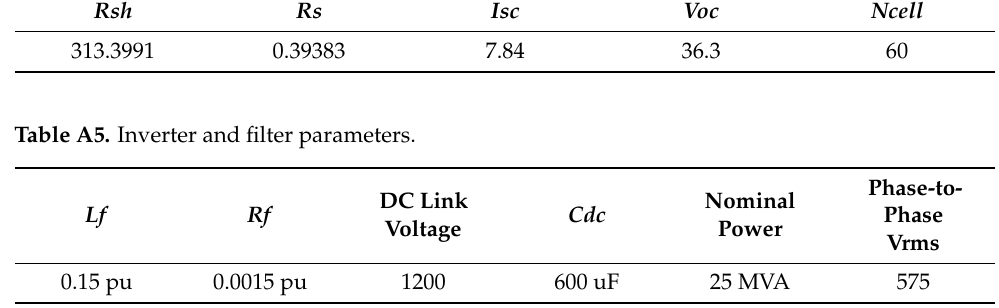
Table A4. Solar module parameters [30].